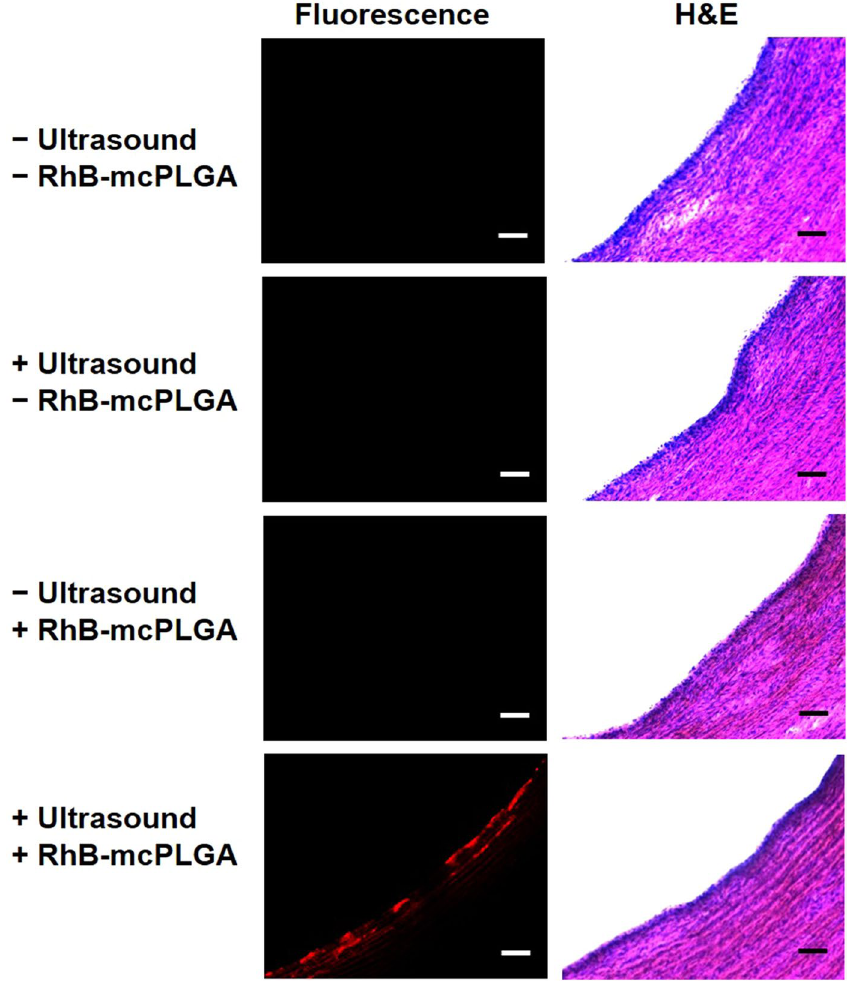
Figure 8. Histopathological analysis by H&E staining of porcine arteries under different treatment conditions. The scale bars represent 100 μ